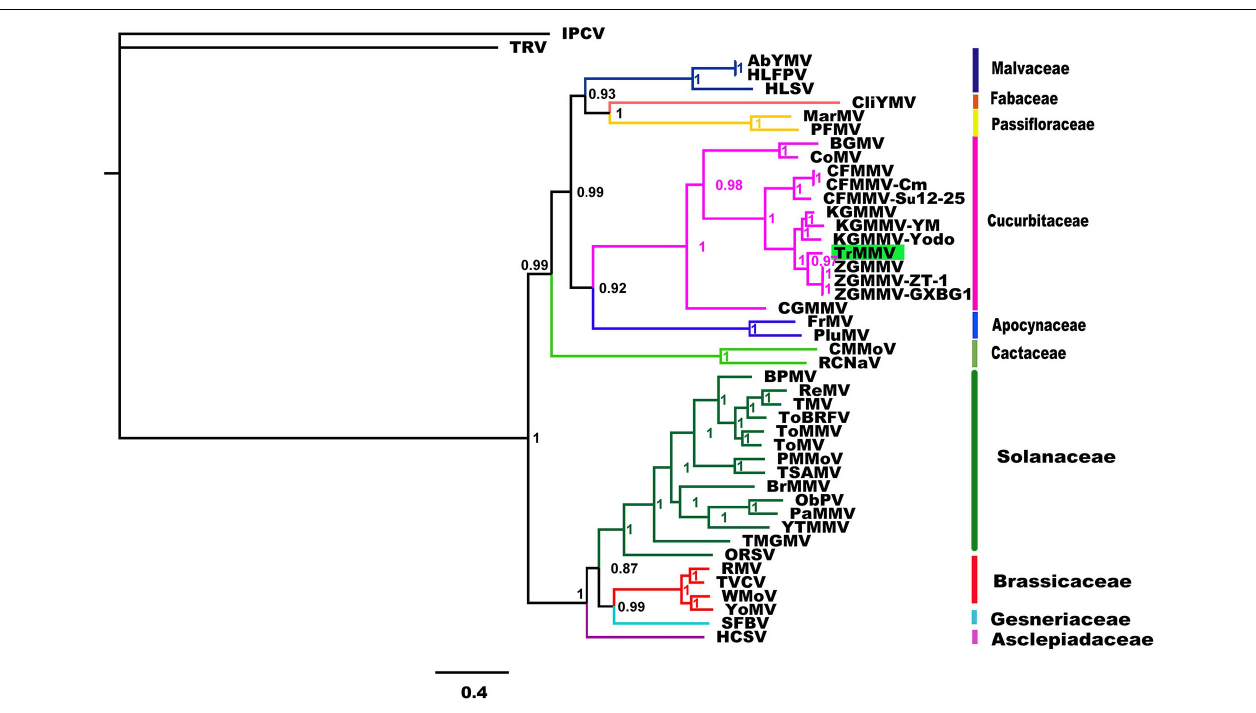
FIGURE 2 | Bayesian phylogenies of whole-genome nucleotide sequences of 43 tobamoviruses. The whole-genome nucleotide sequences of tobacco rattle virus (TRV) and Indian peanut clump virus (IPTV) were used as the outgroups. Support values are Bayesian posterior probabilities. Species and the NCBI accession number used for phylogenetic analyses are provided in Supplementary Table 2